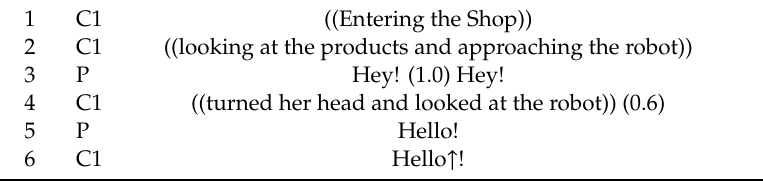
Table 3. Conversation in the attention estimation model condition (10 September